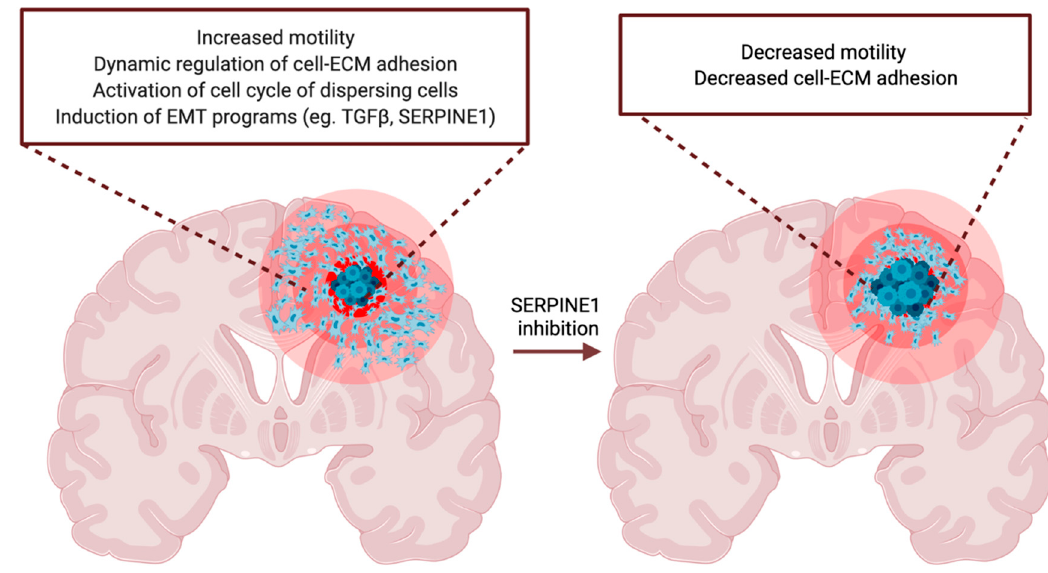
Figure 4. Effect of SERPINE1 on glioblastoma cell invasion. Transcriptome profiling of motile and nonmotile glioblastoma cells identified SERPINE1 as a regulator of glioblastoma cell motility. Inhibition or knock-down of SERPINE1 reduces glioblastoma cell invasion by regulating cell adhesion and directional persistence of the cells. As a result, SERPINE1 inhibition has the potential to reduce tumor progression in vivo. Figure generated at Biorender.com (adapted from Seker, F., et al. [149]).